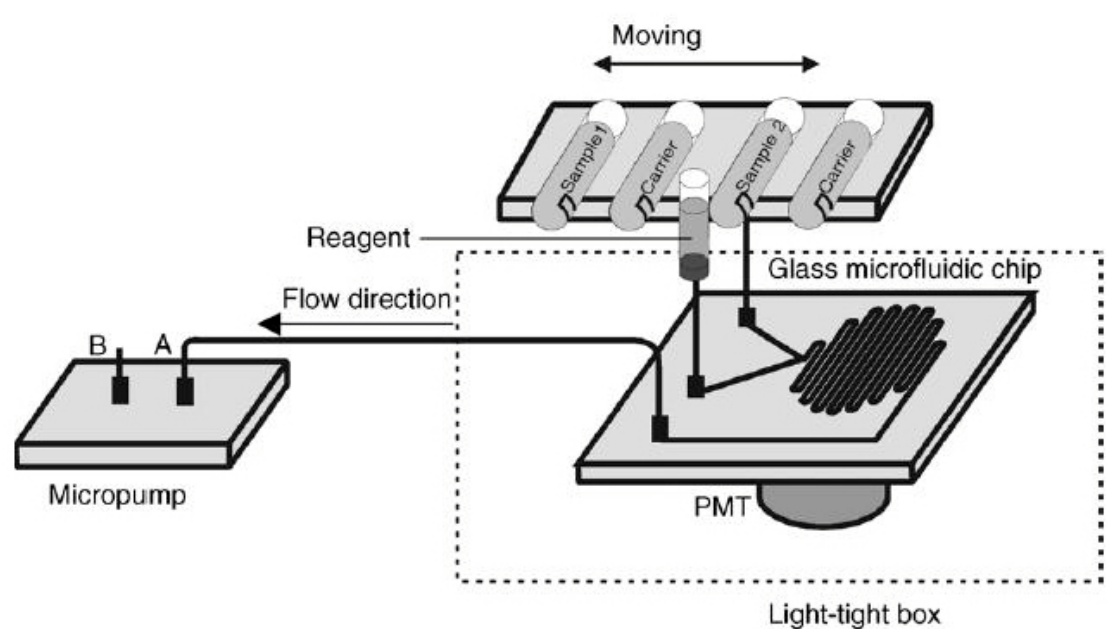
Figure 6 Schematic diagram of the microfluidic flow injection CL